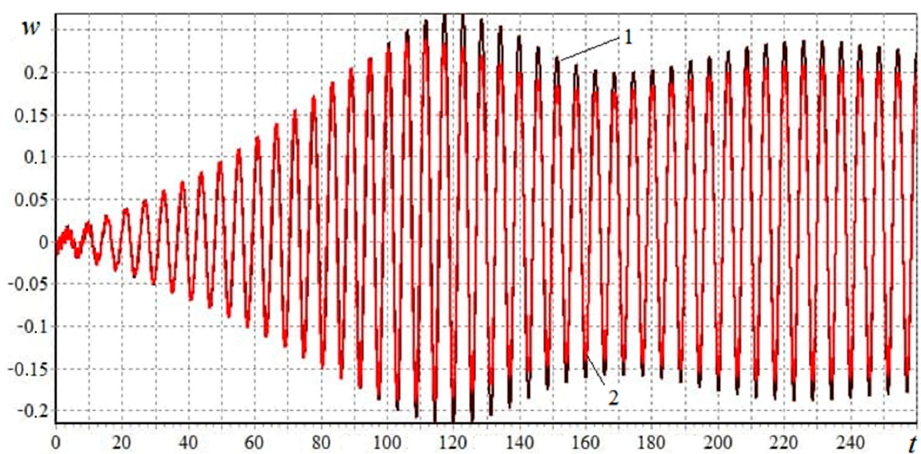
⊗ = 1.1; (2) A ⊗ = 1.3. ij = 0.02, ij = 0.02,